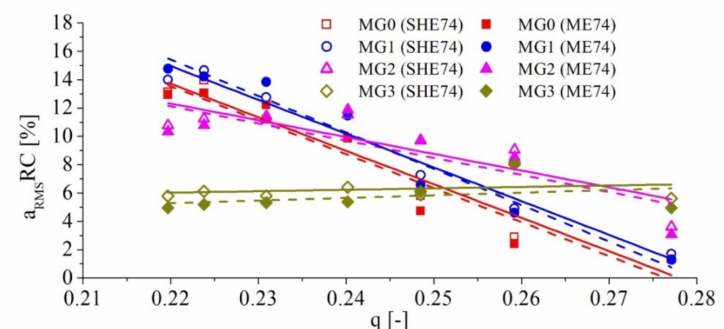
Figure 10. The dimensionless equivalent amplitude of the rotating component (RC) induced by the self-induced flow instabilities on the cone wall of the test section (MG0, MG1, MG2 and MG3) for two draft tube configurations (SHE74—solid line, ME74—dashed line) versus the discharge coefficient. Linear fits of the experimental data given by solid and dashed lines highlight the